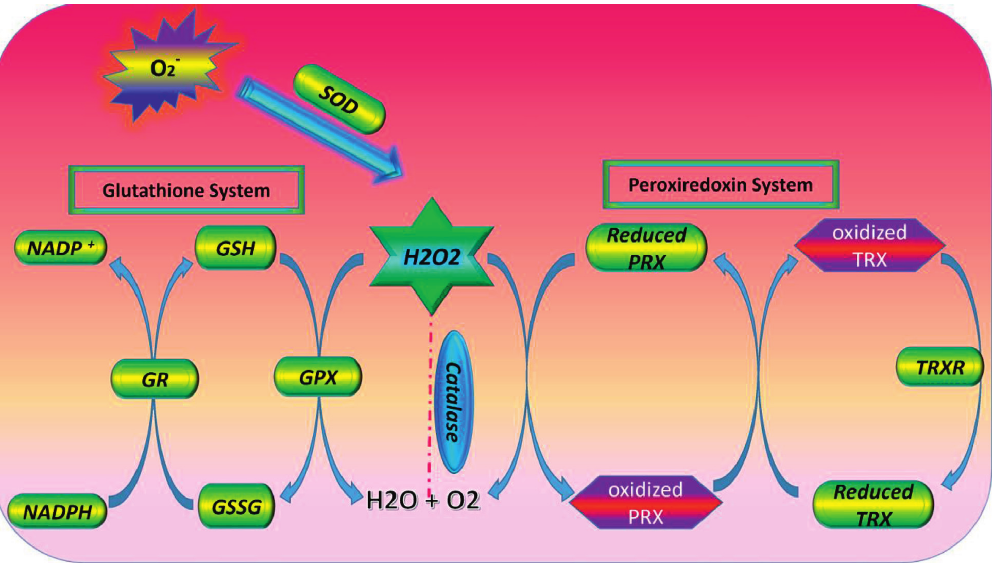
Figure 1: Antioxidant enzymes. The superoxide radical anion can be transformed either to H converted to H 2 O and O 2 by CAT and/or GPX/PRX. H 2 O 2 , hydrogen peroxide; SOD, superoxide dismutase; CAT, catalase; GPX, glu- tathione peroxidase; PRX, peroxiredoxin